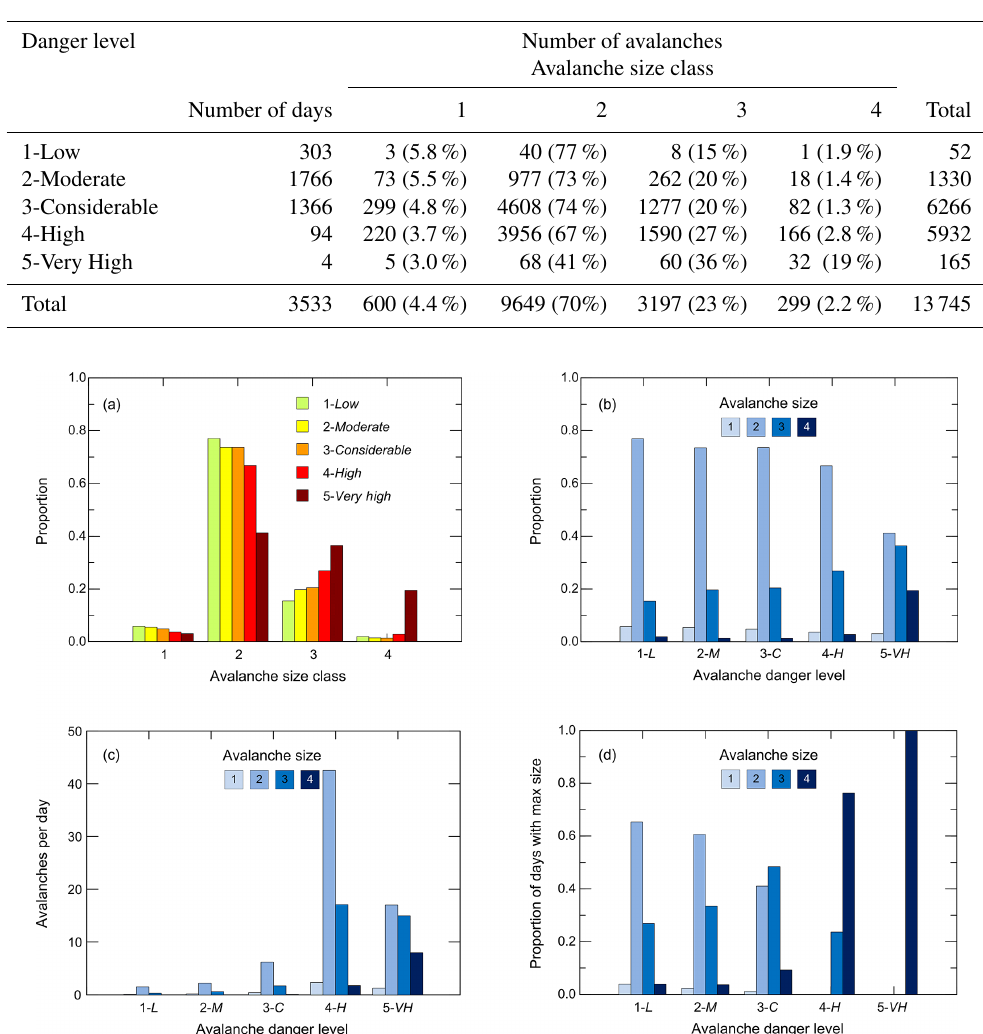
Figure 3. Avalanche size per danger level. (a) Relative frequency of avalanche sizes (1 to 4) at the danger levels 1-Low to 5-Very High. (b) Distribution of avalanche size for each danger level (same data as in Fig. 3a). (c) Average number of avalanches per day by size class for each danger level, for days with AAI > 0. (d) Frequency of days when the largest observed avalanche was size 1, 2, 3 or 4 for each danger level. N = 13745 avalanches on